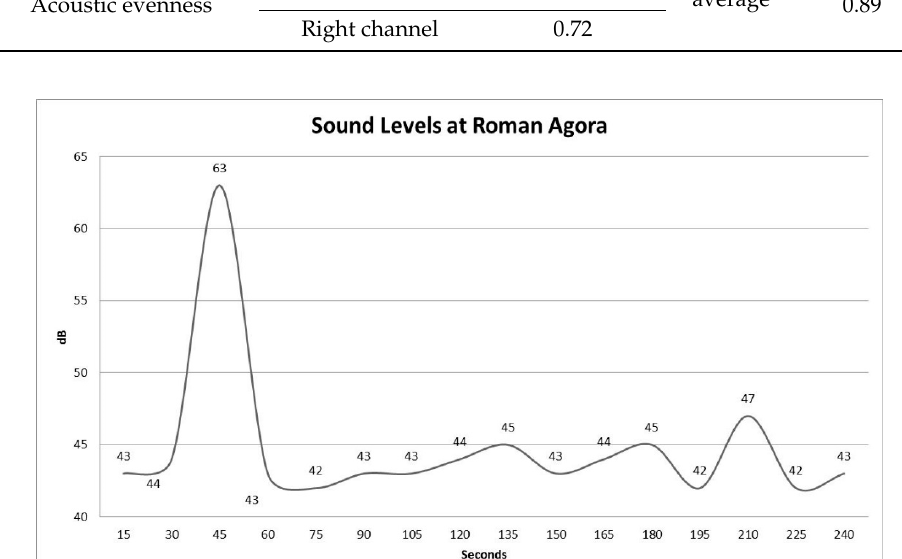
Figure 3. A graph showing levels of noise (dB) in the Roman Agora.